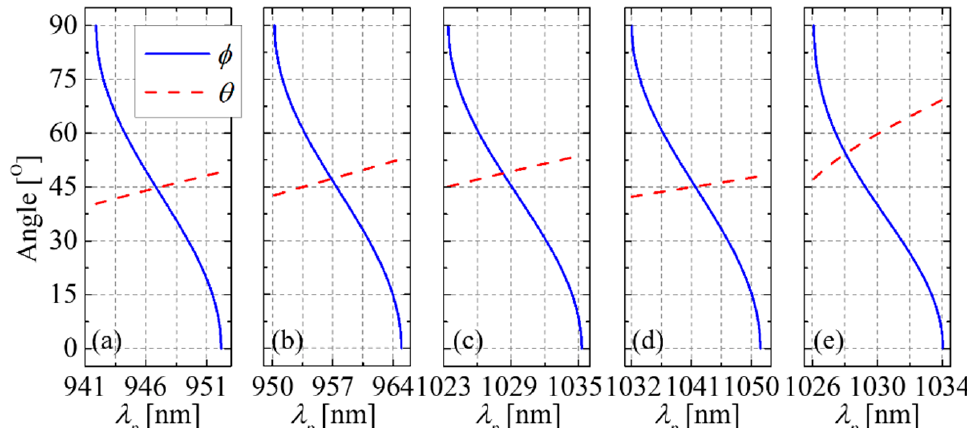
Figure 3. k -directions ( φ and θ ) for Type II EPM and the corresponding resonant pump wavelength ( λ p ). The EPM is possible for all azimuthal angles ( φ = 0–90 ° ), whereas for polar angles ( θ ), only in a specific angular region: ( a ) KTP, ( b ) RTP, ( c ) RTA, ( d ) KTA, and ( e ) CTA. Table 2. k -direction and wavelength ranges of the interacting photons satisfying Type II EPM.